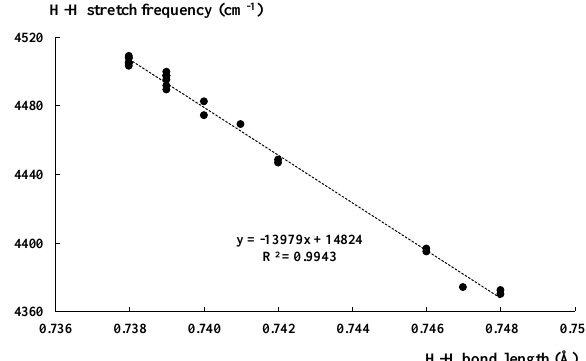
Figure 2. The linear correlation between the H-H bond length (Å) and the corresponding H-H bond stretching frequency (cm −1 ).